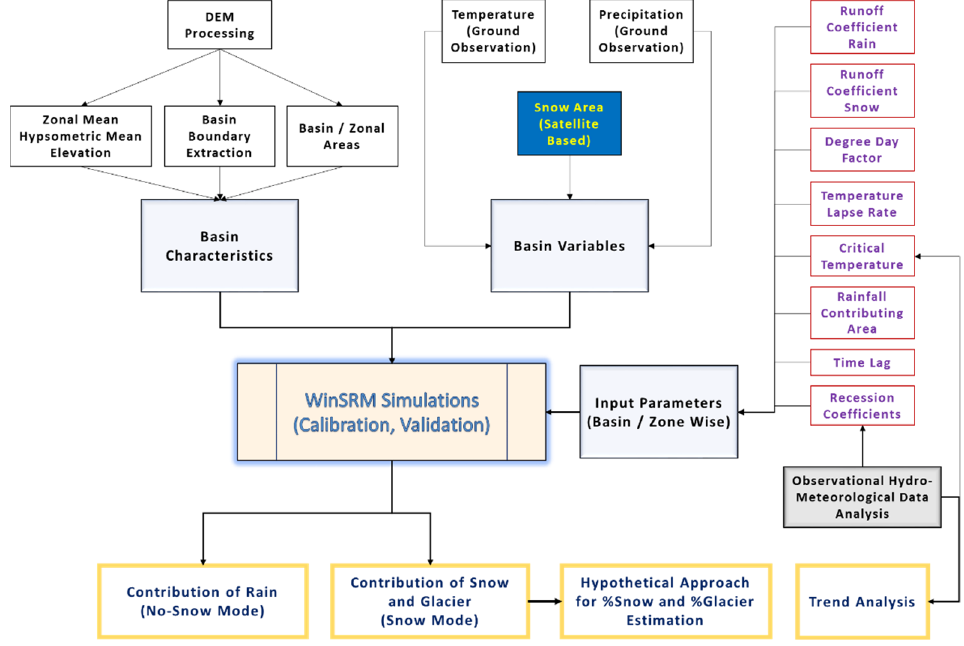
Figure 5. Flowchart explaining methodology used in the study.